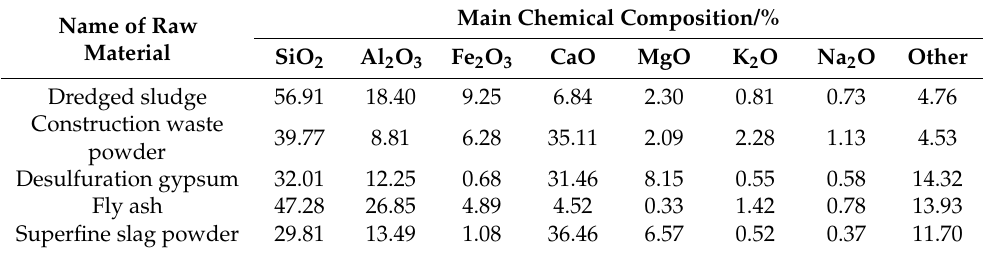
Table 1. Chemical composition of test